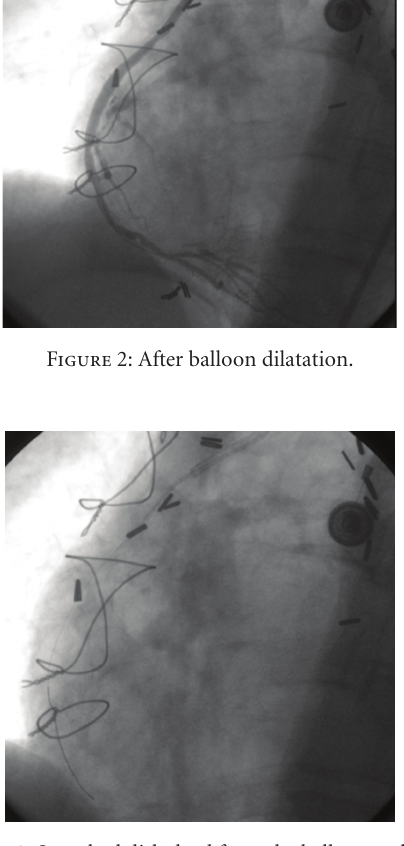
Figure 3: Stent had dislodged from the balloon catheter.